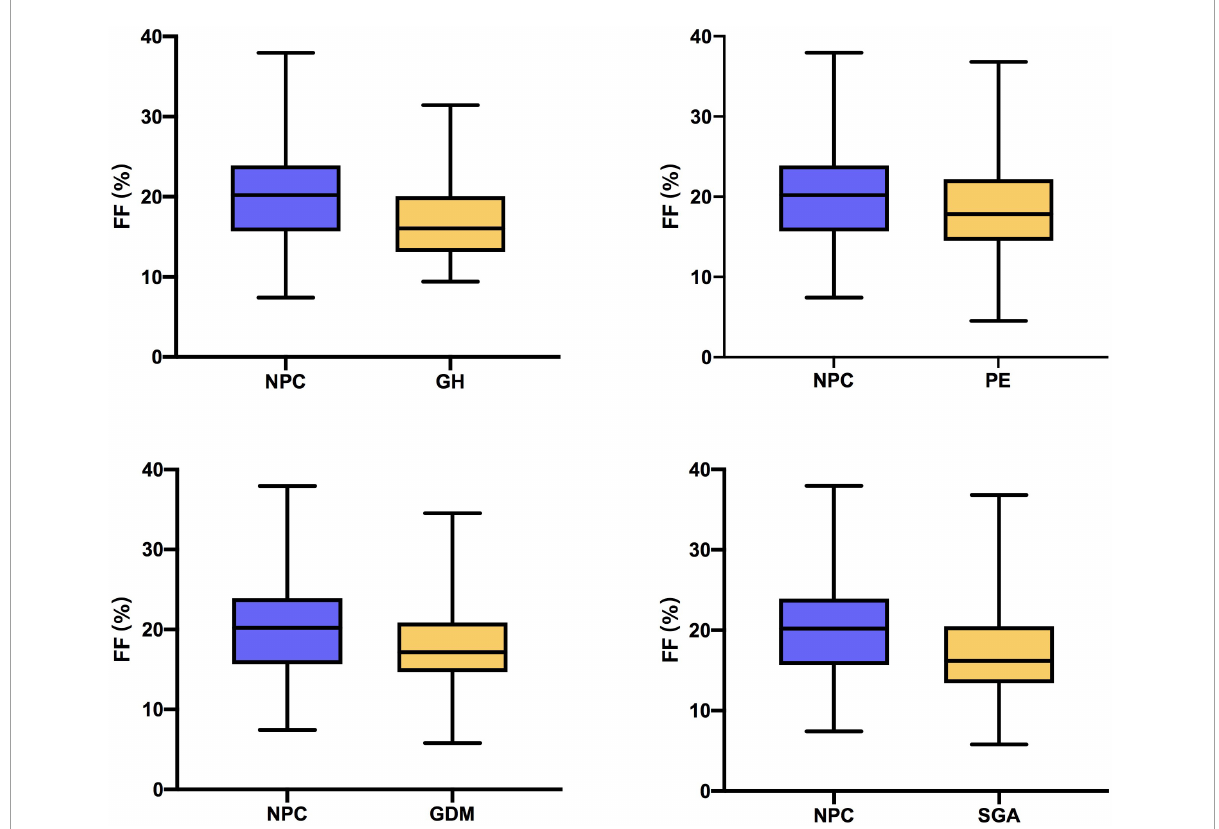
FIGURE2 Fetal fraction (FF) in women with non-pregnancy complication (NPC) and women who developed gestational hypertension (GH), preeclampsia (PE), gestational diabetes mellitus (GDM), and small for gestational age